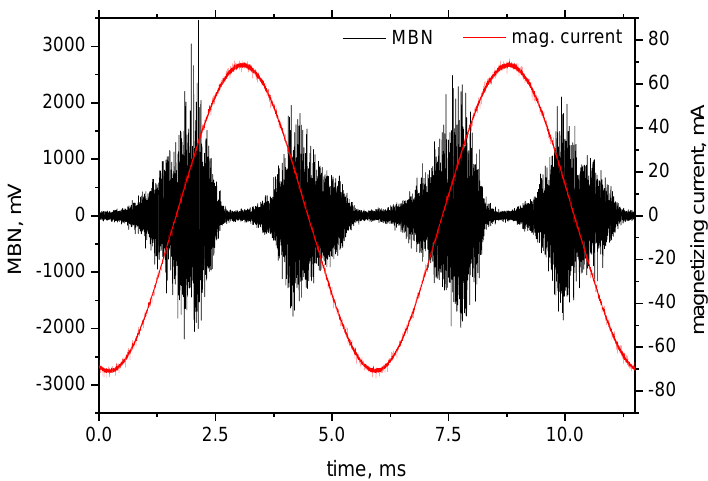
Figure 11. MBN signal, ε = 15%, magnetising voltage 5V, magnetising angle 0° (RD).